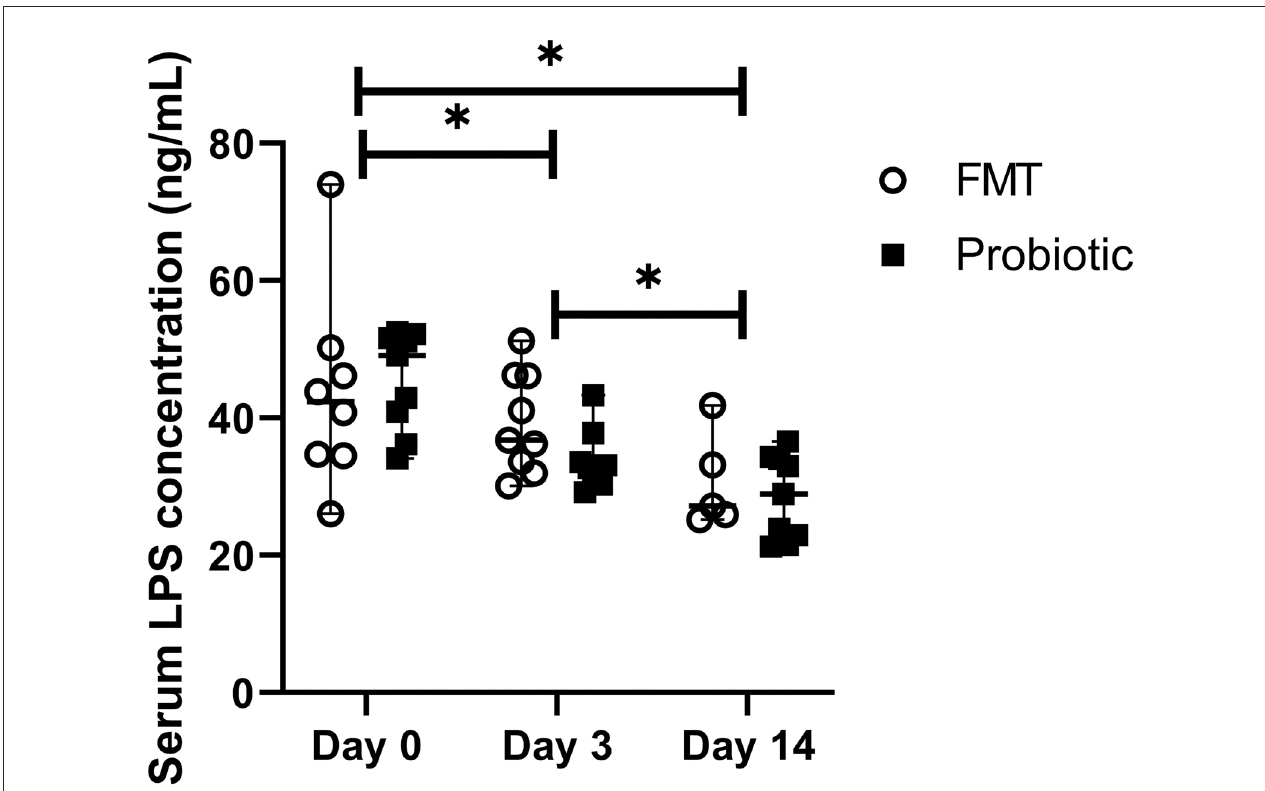
FIGURE2 Line plot of serial serum lipopolysaccharide (LPS) concentrations in 18 dogs with acute hemorrhagic diarrhea syndrome receiving either fecal microbiota transplant (FMT) or probiotic. Data are expressed as median (range); data points represent individual dog values. Asterisk (*) indicates a significant difference ( p < 0.05) when comparing baseline vs. days 3 and 14 and day 3 vs. day 14 in all